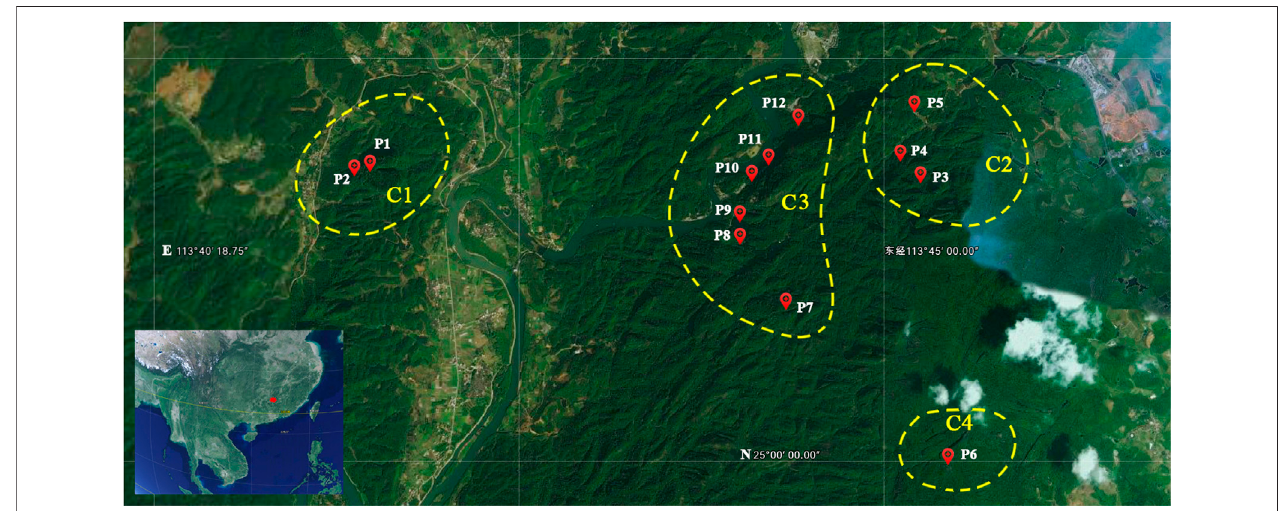
FIGURE 2 | Geographic locations of the 12 populations of Primulina danxiaensis . C1 – C4: four clades of the phylogenetic tree. P1 – P12: population ID for the 12 populations of P. danxiaensis .